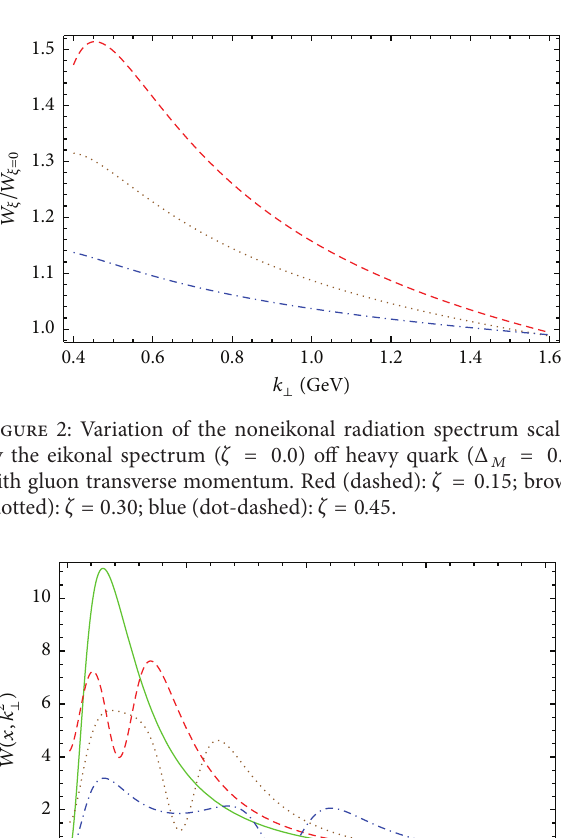
radiation spectrum off light quarks. Below we jot down the forms of the functions 𝑓 𝑖 , ∀𝑖 = 1 → 5 , 𝐴 → 𝐷 , and C 1 , C 2 , C 0 , when we take massless limit, that is,